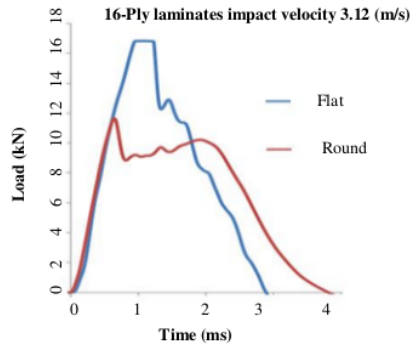
Figure 7: Load-time history of 16-Ply laminate under flat and round nose